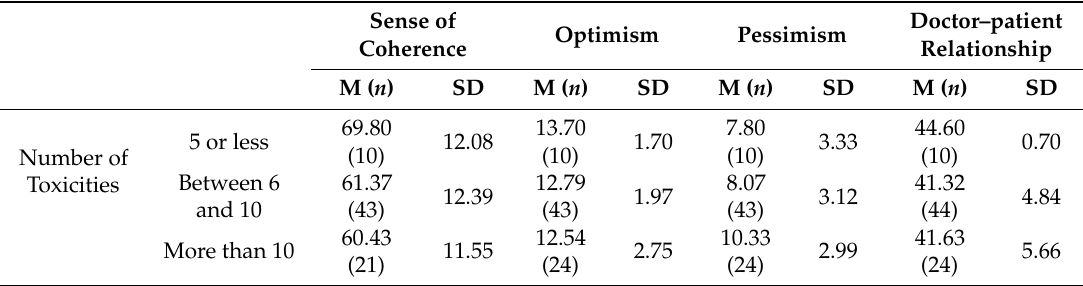
Table 2. Sense of coherence, dispositional optimism, and doctor–patient relationship related to the number of toxicities per patient and chemotherapy cycle. Sense of Optimism Coherence